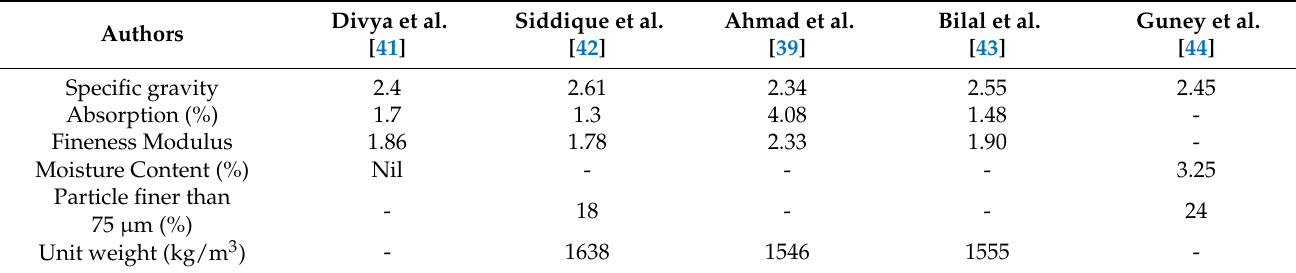
Table 1. Physical properties of WFS.